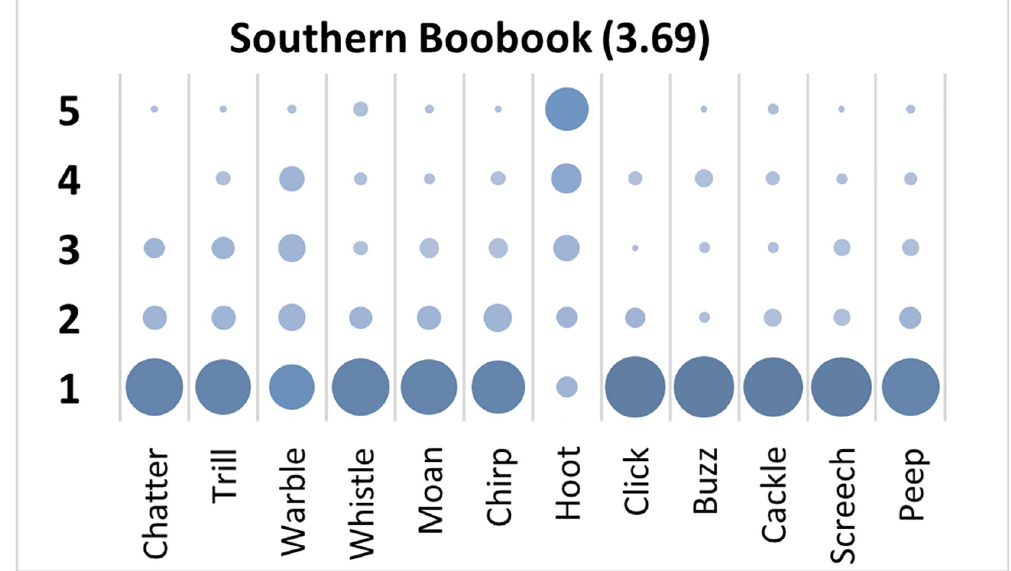
Fig 2. Count of participants’ sound descriptions scores for the Southern Boobook call with confidence ratings in